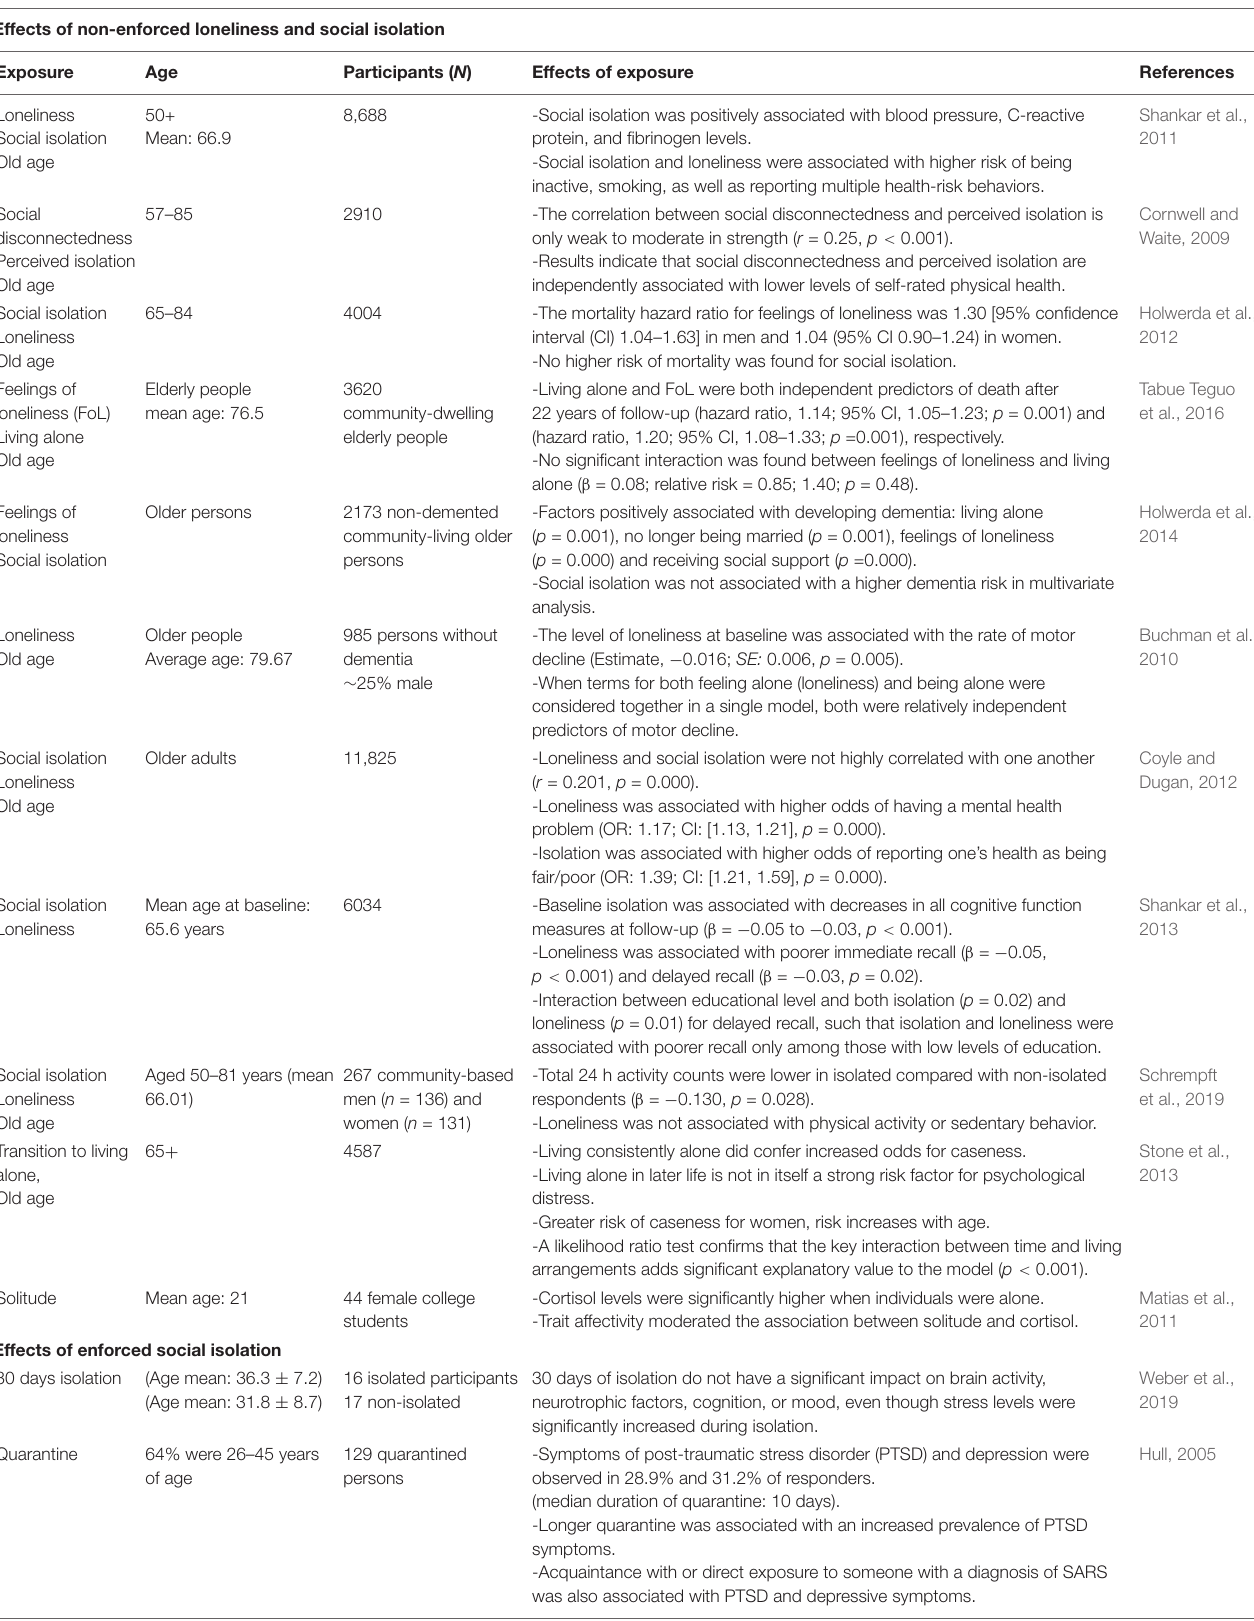
TABLE 1 | Physiological and mental health effects of decreased social interactions in